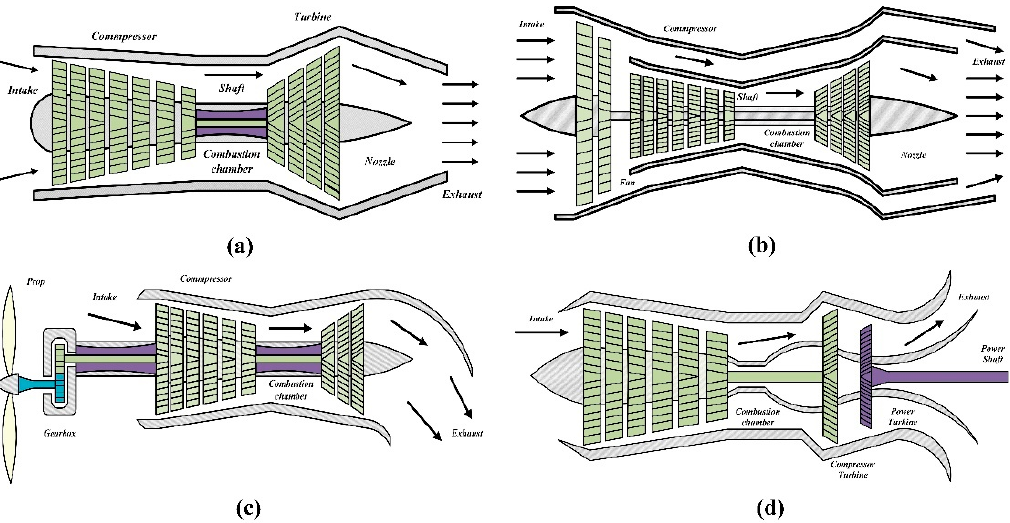
Figure 9. Structure of turbo engines. ( a ) Turbojet [66]; ( b ) Turbofan [69]; ( c ) Turboprop [70]; ( d ) Turboshaft [71].